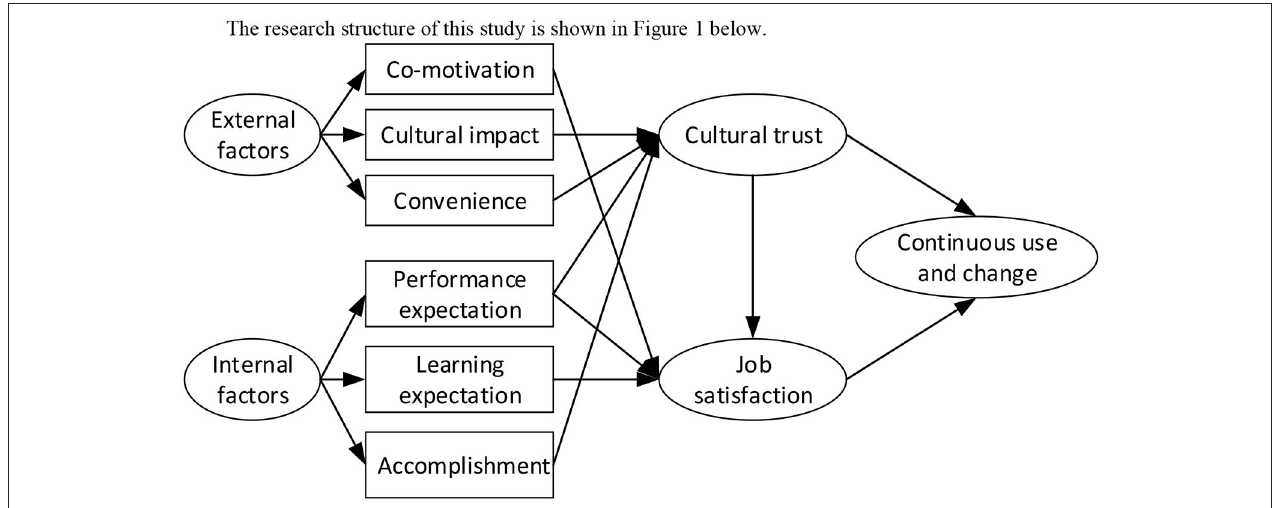
FIGURE 1 | Analysis of